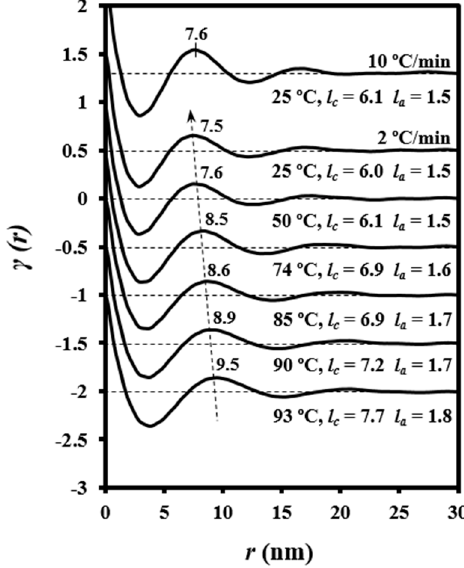
Figure 12. Correlation functions of patterns obtained at the indicated temperatures during the cooling run (2 °C/min) from the melt state. The correlation function of the pattern obtained at room temperature after cooling at 10 °C/min is also shown for comparative purposes.